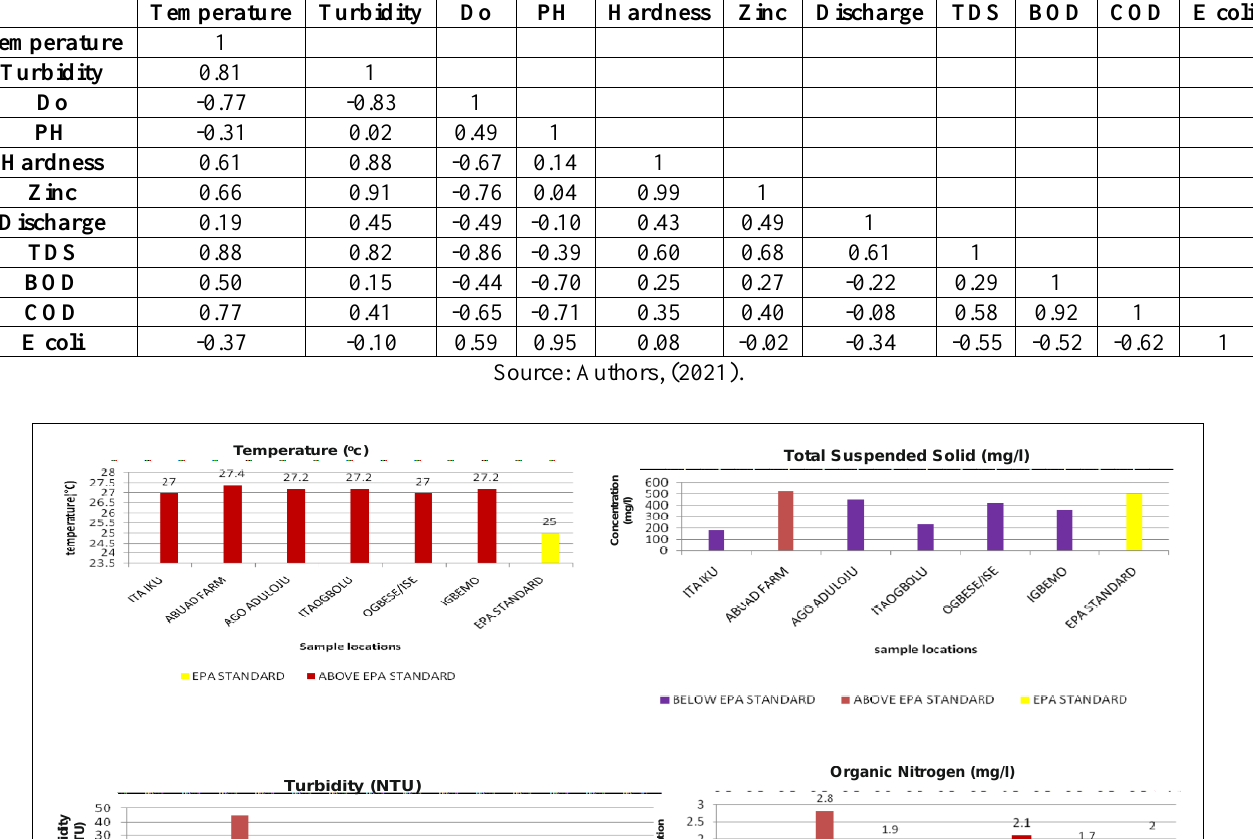
Table 4: Correlation coefficient of some of the water quality parameters in the study.